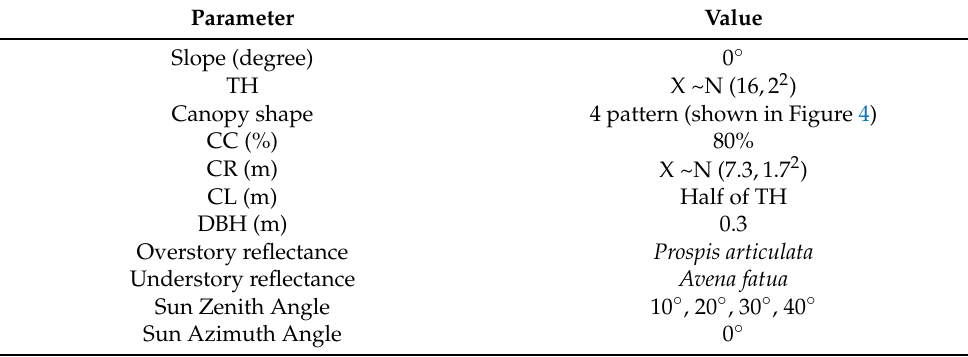
Table 2. Characteristics of the forest scenes and optical parameters used in the